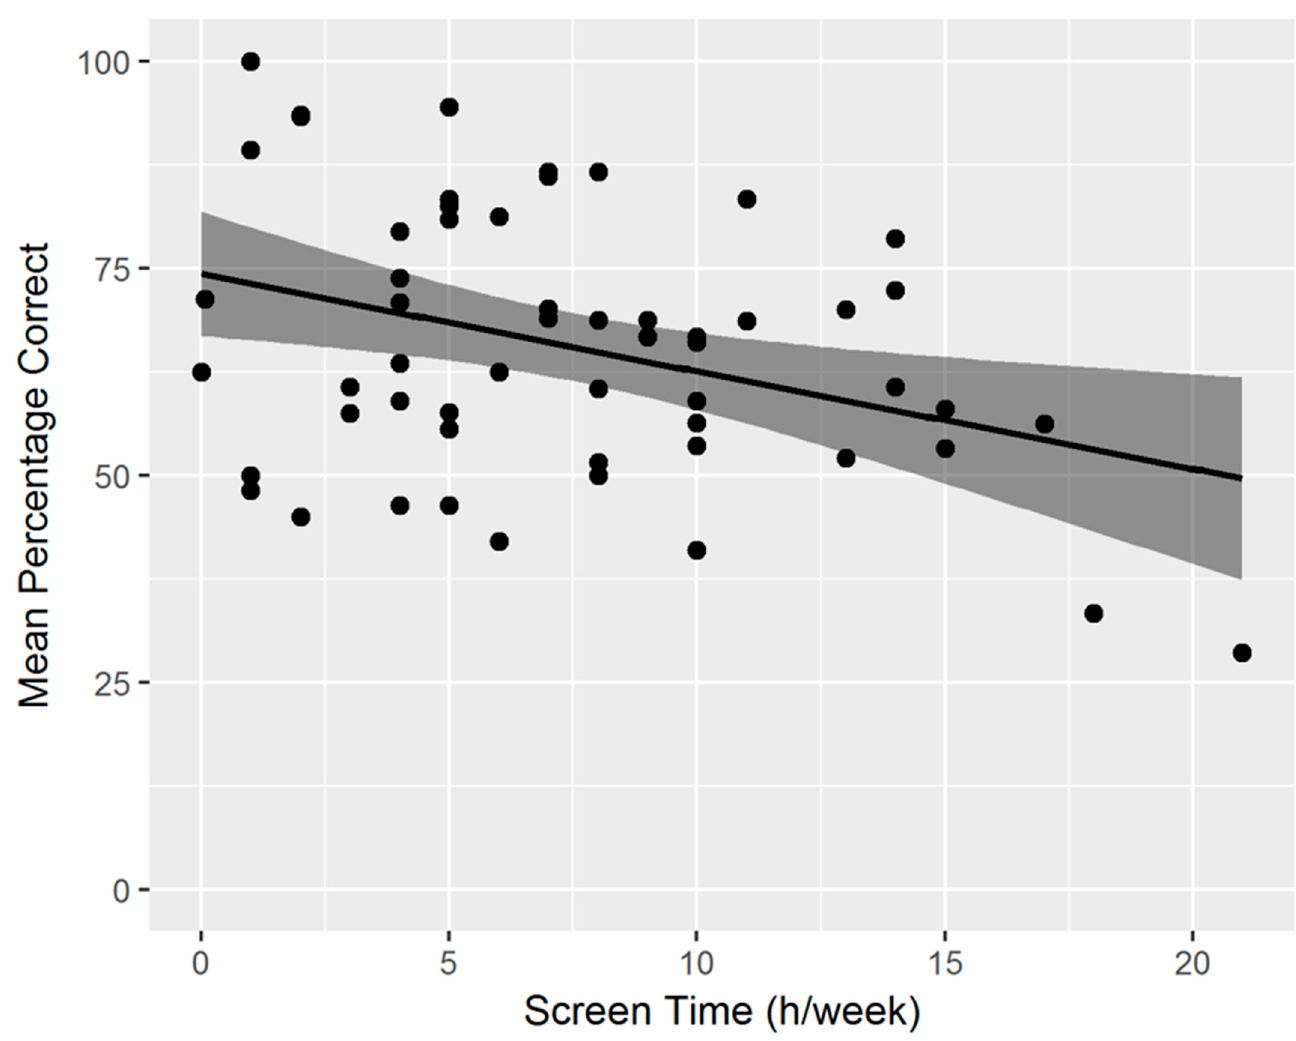
Figure 4. The relation between screen time and task performance (mean percentage correct).